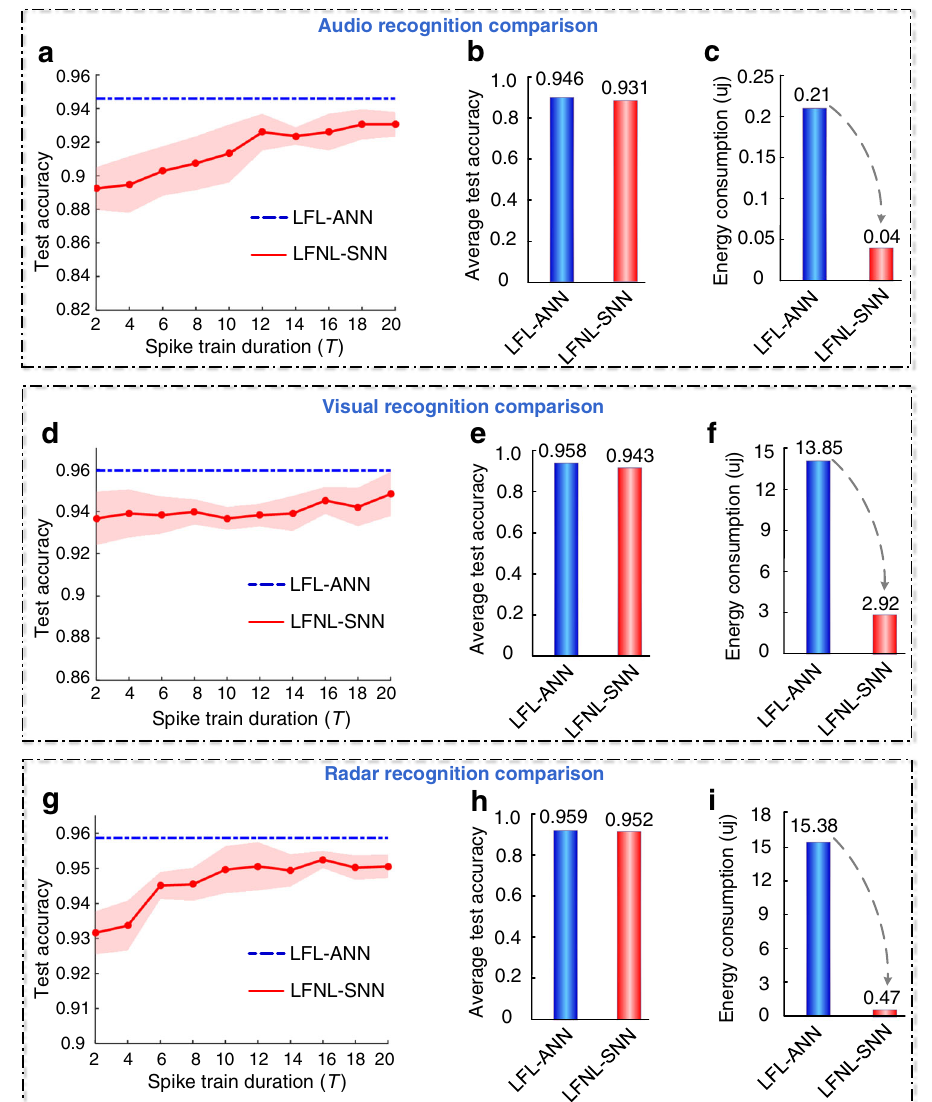
Fig. 5 | Recognition accuracy and computation energy comparisons between ANNs and SNNs trained on the audio, vision and radar datasets. a Audio classi fi cation accuracy comparison between LFNL-SNN and LFL-ANN versus the spike train duration T of the operation of SNNs on the traf fi c sound dataset. Both SNNs and ANNs have the same learning structure with 128-500-3 neurons (for input-hidden-label layers). b , c Average test accuracy and energy consumption comparisons when the spike train duration T is 15. d Visual classi fi cation accuracy comparison between LFNL-SNN and LFL-ANN versus T of SNNs on traf fi c image